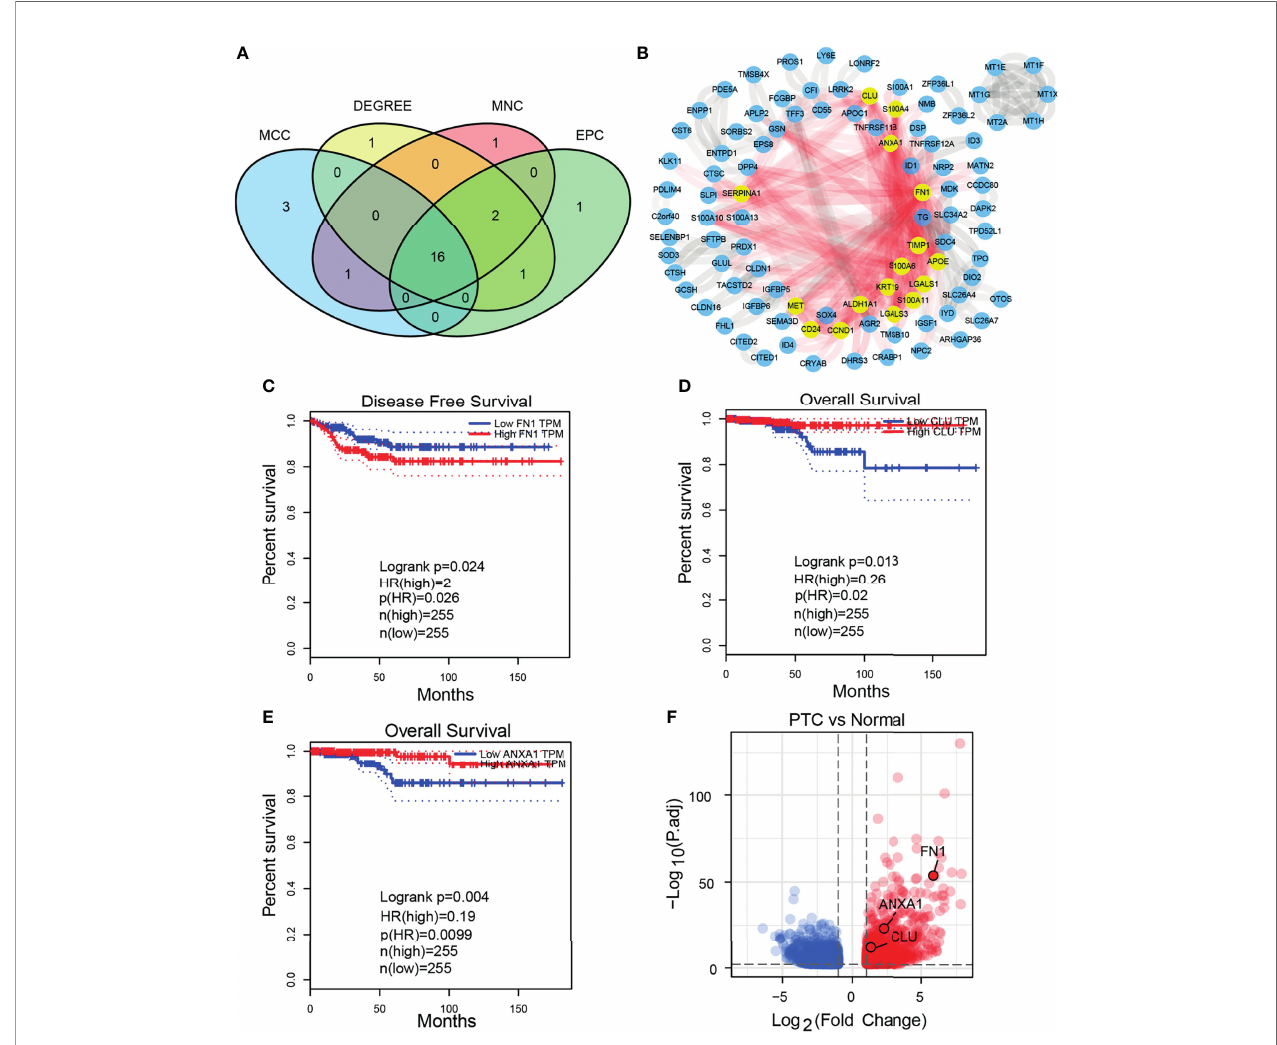
FIGURE 3 | Hub DEGs and 3 prognostic related DEGs. (A) Venn plot of 16 hub DEGs screened by four algorithms in CytoHubba. (B) 16 hub DEGs in PPI network. (C – E) The 3 prognostic related DEGs analyzed by GEPIA2 (both Disease Free Survival and Overall Survival). (F) GSEA analysis HALLMARK pathway (upregulated in normal